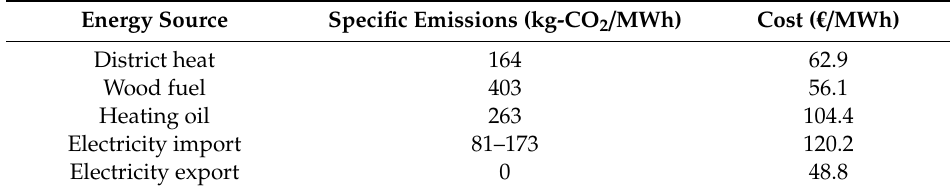
Table 3. The emissions [49,50] and costs of di ff erent energy sources [51–55]. For electricity, the average cost is